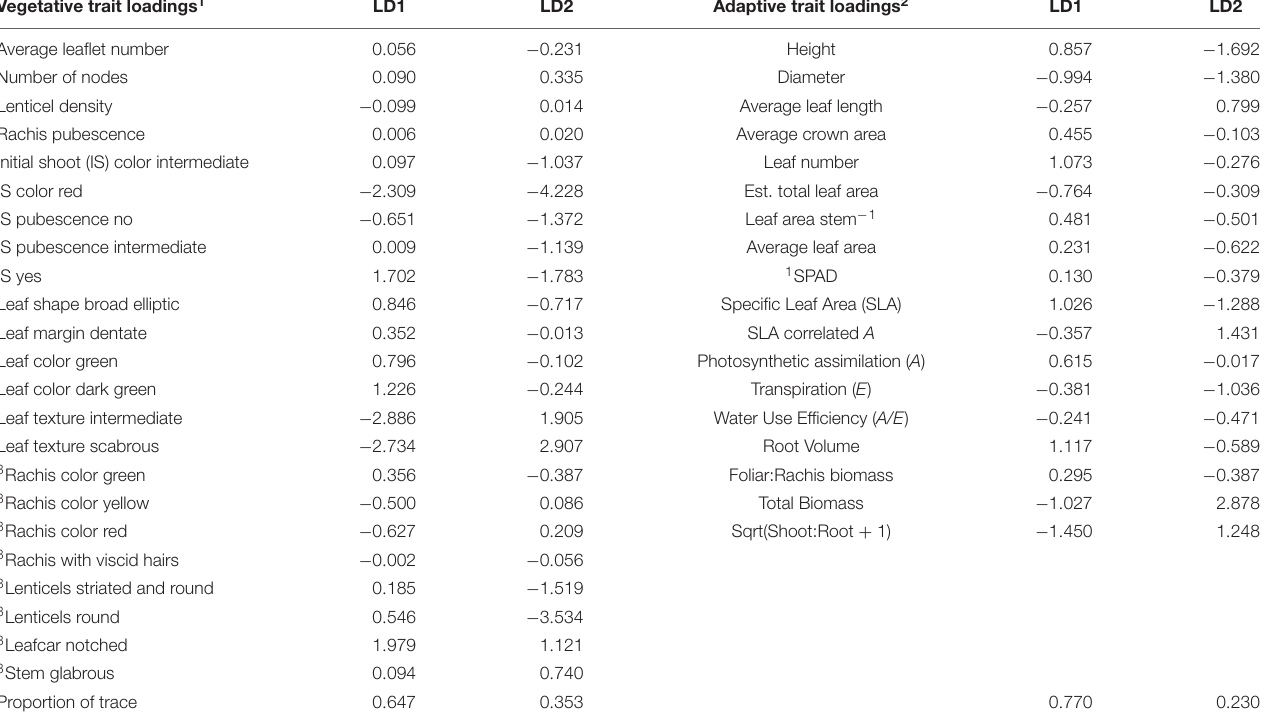
TABLE 3 | Loading values for vegetative and adaptive traits as assigned by canonical discriminant analysis.